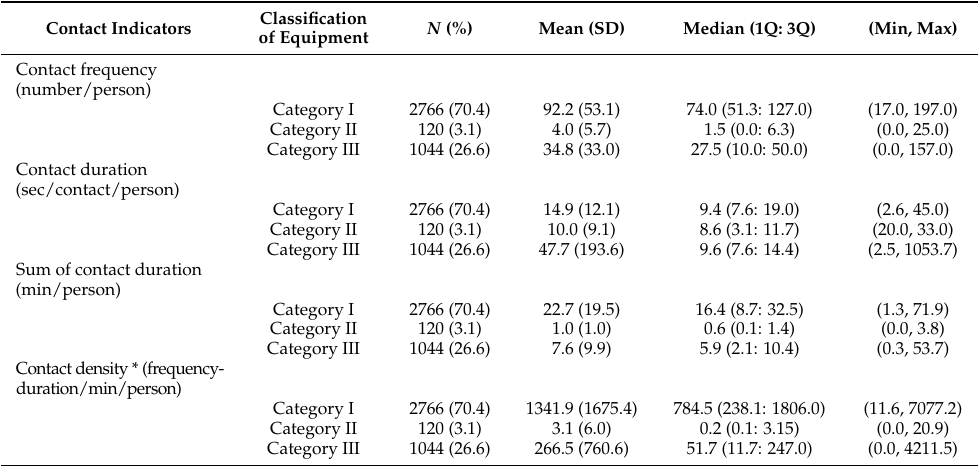
Table 3. Descriptive statistics of hand to environment contact by category for risk of contact trans- mission (2-hours observation time, n = 3,930, N = 30